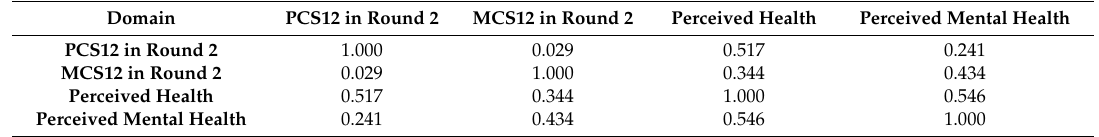
Table 3. Construct Validity (Convergent and Discriminant) of PCS-12 and MCS-12 in SF-12v2 a .